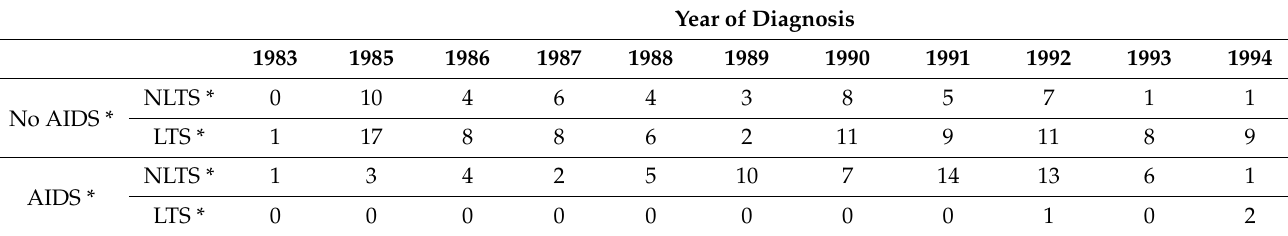
Table 3. Year of diagnosis and AIDS at